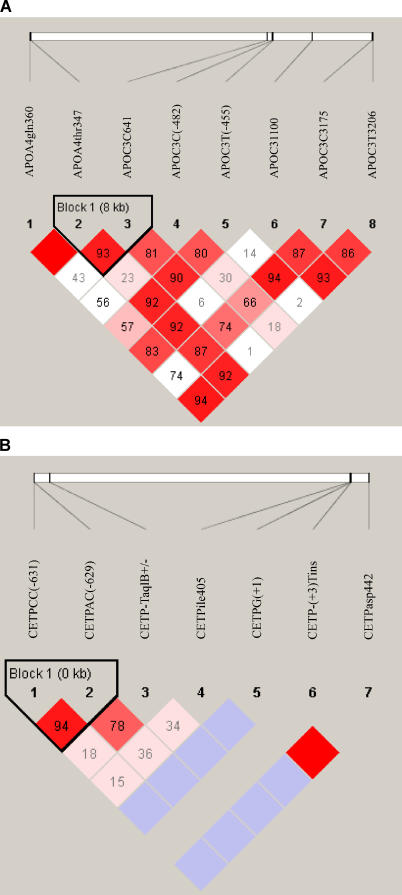
Haplotype Structure of
APOC3 and
APOA4 and
CETP
Ordinal arrangement of 15 SNP associated with CVD and lipoprotein metabolism, according to their position on chromosomes with LD (number in boxes) where the highest rate is represented in red and no LD in lilac. Blocks define potential haplotypes between two clustered genes.(A)
APOC3 and
APOA4.
(B)
CETP.